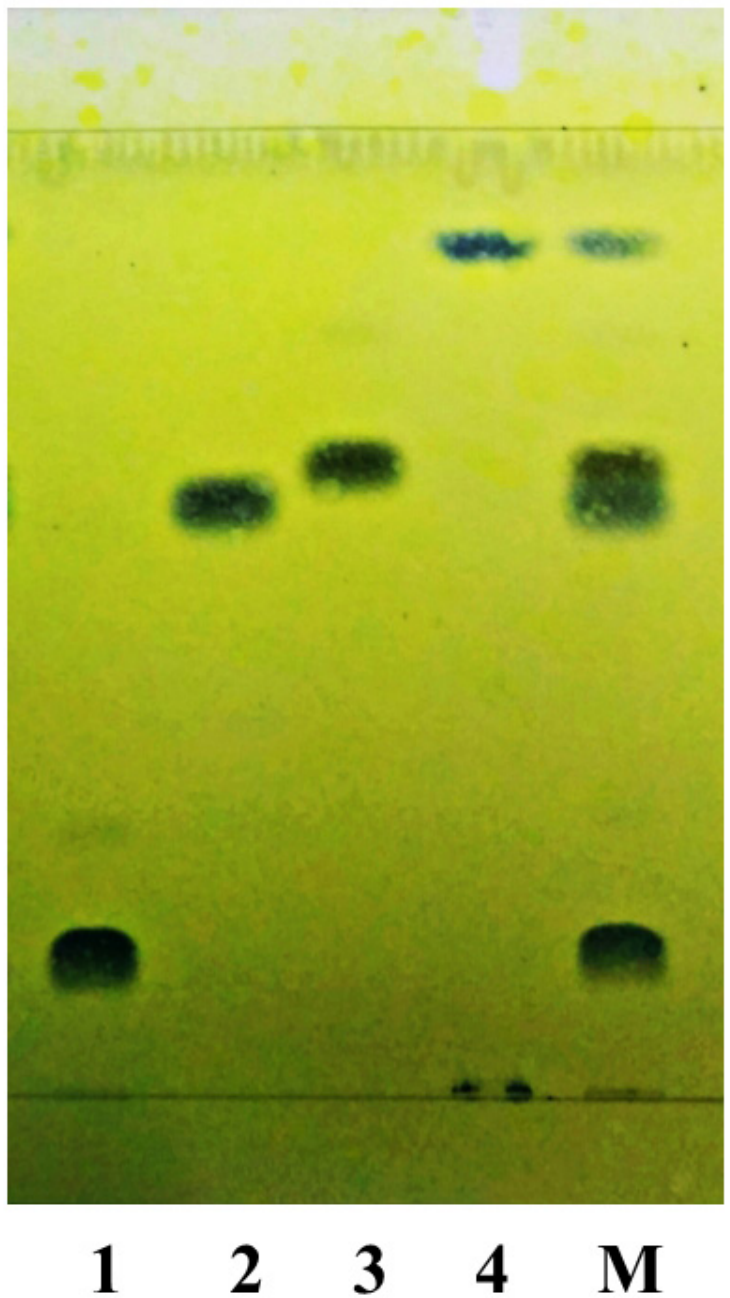
FIGURE 2 - TLC separation of the authentic BAs. Standards of CA (1), CDCA (2), DCA (3) and LA (4) were set to be 1 mg/ mL. Each of standard and their mix (M) were dissolved in methanol and spotted for 10 µL onto silica plates with the help of Linomat